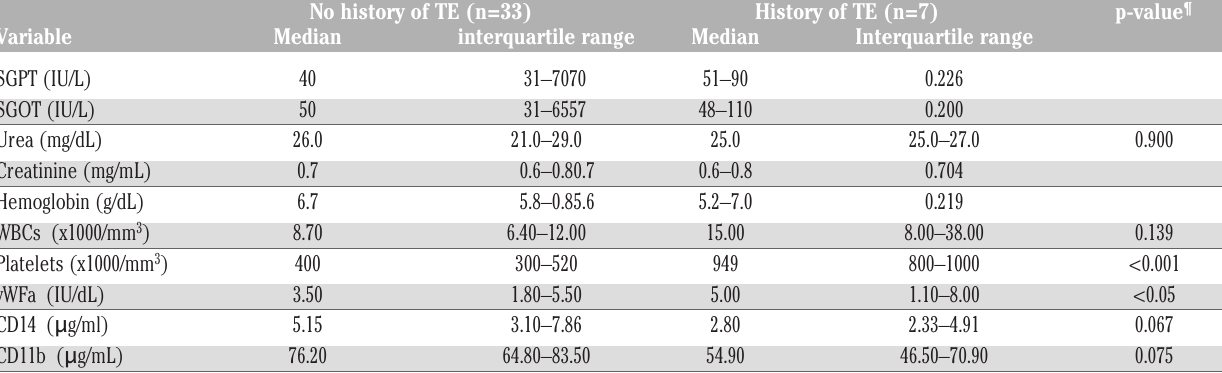
Table 4. Relation between laboratory variables, vWFa, CD14 and CD11b and the development of TE in thalassemic patients. No history of TE